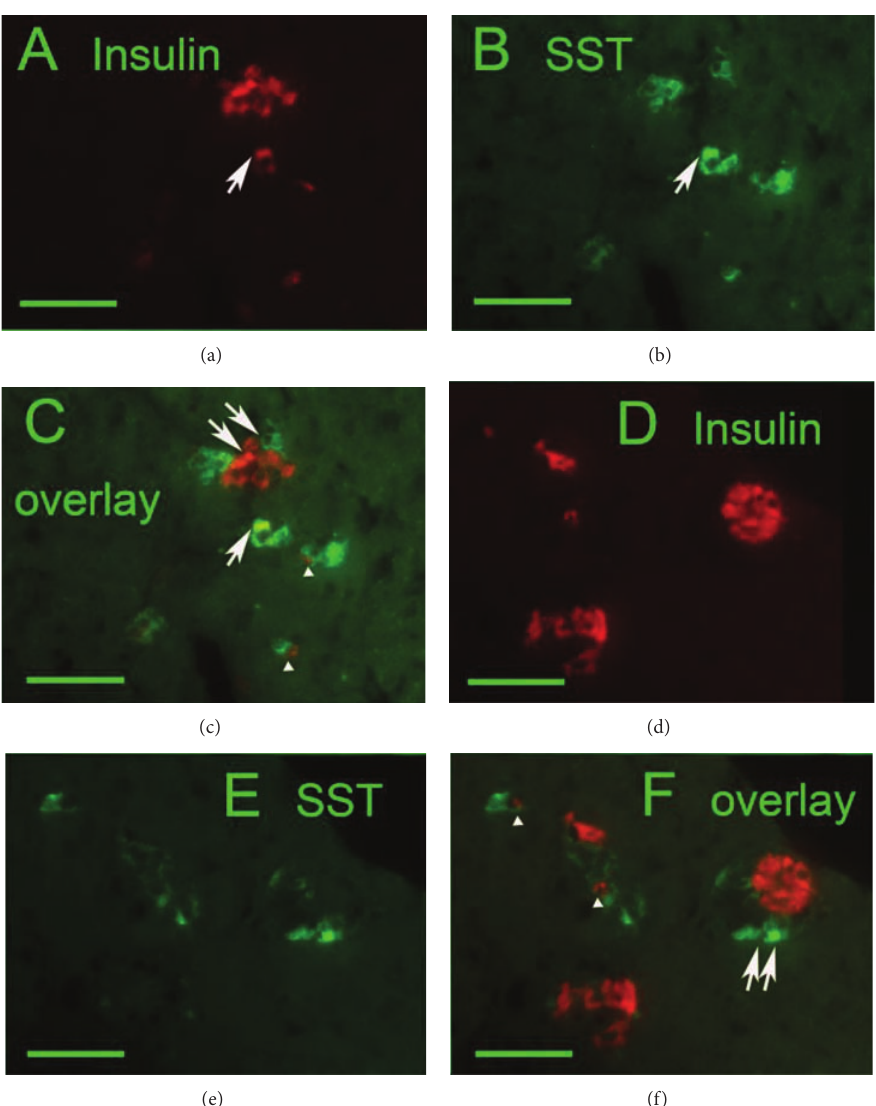
Figure 2: Delta cell proliferation in exocrine glandular tissue ((a), (d) insulin : red , (b), (e) SST : green , and (c), (f) overlays) of 79-week-old Goto-Kakizaki rats. Individual exocrine cells present simultaneous content of insulin and SST (arrows). Coupling of individual SST- and insulin-positive endocrine cells was frequently noticed (arrowheads). Image of small proliferating endocrine masses indicates also beta and delta cells polarization (double arrows). Original magnification 400x; scale bars 50 𝜇